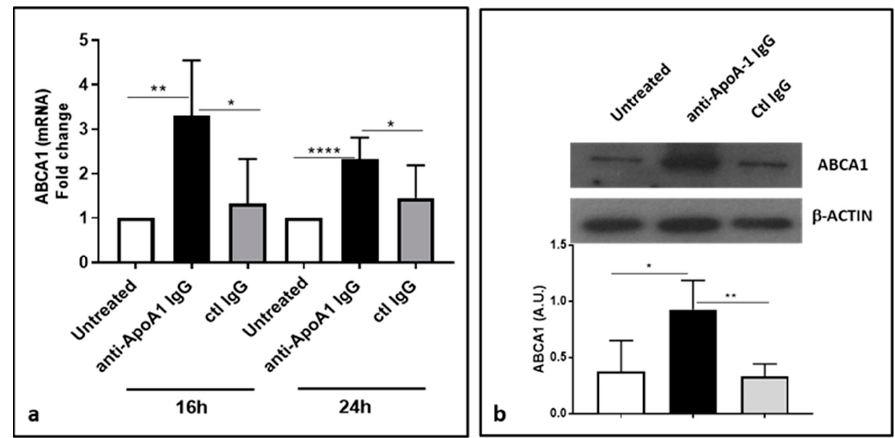
Figure 6. Anti-ApoA-1 IgGs upregulate ABCA1. ABCA1 was increased after 16 and 24 h of anti-ApoA-1 IgG exposure to HMDM at the mRNA level as revealed by RT-PCR ( a ) as well as at the protein level after 24 h anti-apoA-1 IgG stimulation, as revealed by Western blot analysis ( b ). In panel a, data are expressed as fold change expression of the mean ± SD of ABCA1 calculated by ∆∆ CT method of six independent experiments ( n = 6) and values were normalized to untreated condition. p -values were calculated using the Student’s t -test: * p < 0.05, ** p < 0.01, **** p < 0.0001. ( b ) One of four representative Western blots is shown. Data are the mean ± SD of band intensity volume / actin intensity volume of four independent experiments ( n = 4). p -values were calculated using the Student’s t -test: * p = 0.02, ** p = 0.005.